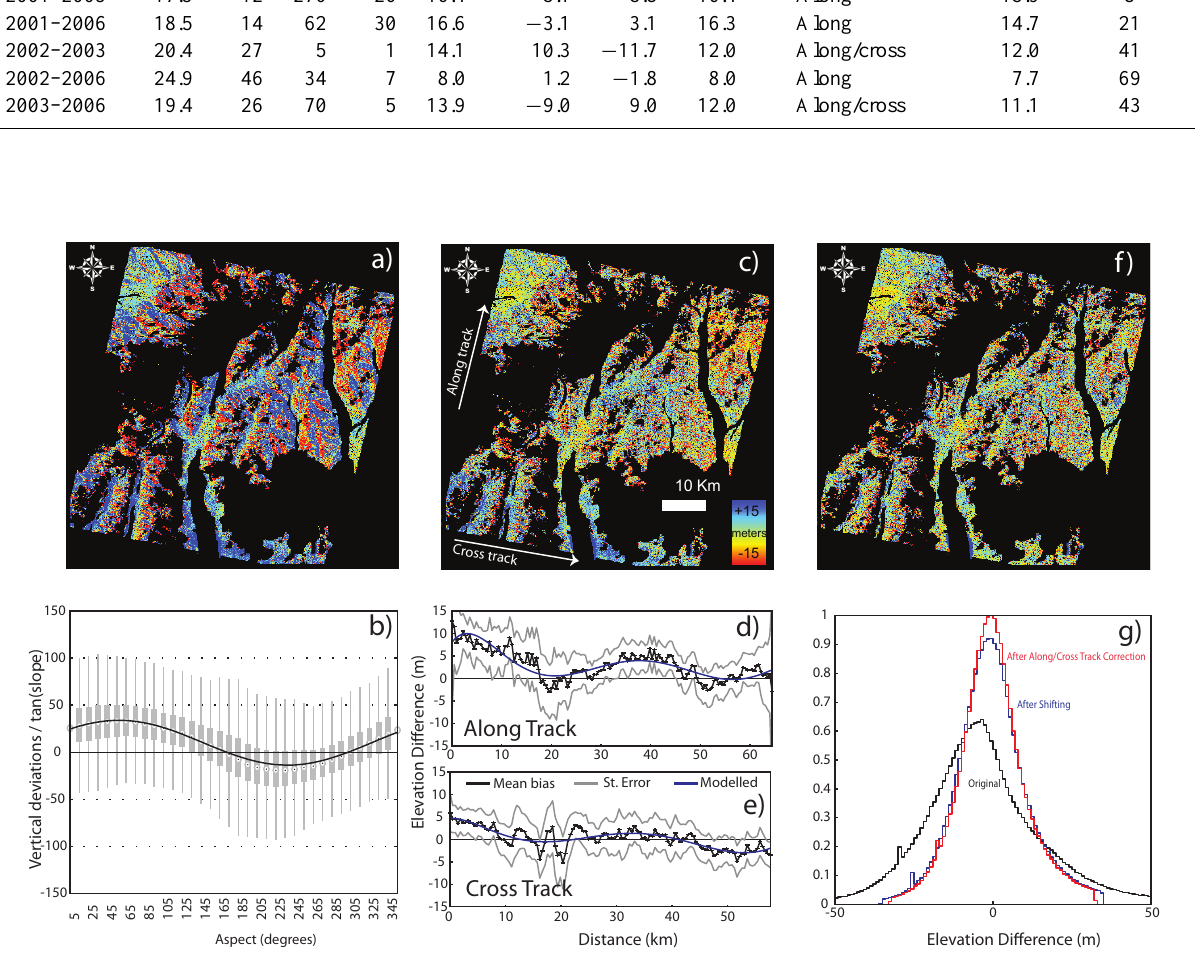
Fig. 4. The processing sequence applied to the 2006 ASTER DEM as compared to the SRTM DEM. (a) Shows the original elevation differences while (b) shows the first iteration relationship to aspect and the cosine-fit solution. (c) Shows the elevation differences after co-registration and (d) and (e) shows the residual relationship to the along track and cross track directions, respectively, with the polynomial correction. (f) Shows the elevation differences after the along and cross track corrections. (g) Shows the final histograms of the three elevation difference maps of (a) , (c) and (f) . All glaciers, lakes, ocean and outliers due to clouds are masked out in